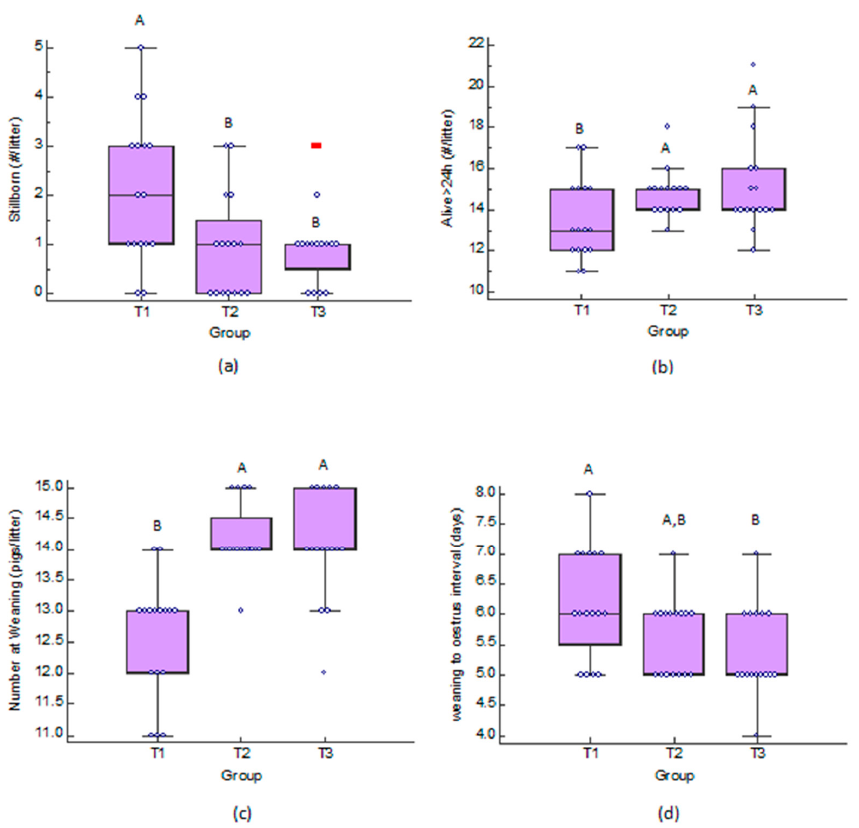
Figure 3. Dot and box and whisker plots of: ( a ) stillborn piglets (#/litter); ( b ) alive over 24 h piglets (#/litter); ( c ) number of weaning (pigs/litter); and ( d ) weaning to estrus interval (days), in control group (T1), group fed with PFA-1 (T2) and group fed with PFA-2 (T3). #: Number; A,B Different letters above bars are indicative of significant difference ( p < 0.05).